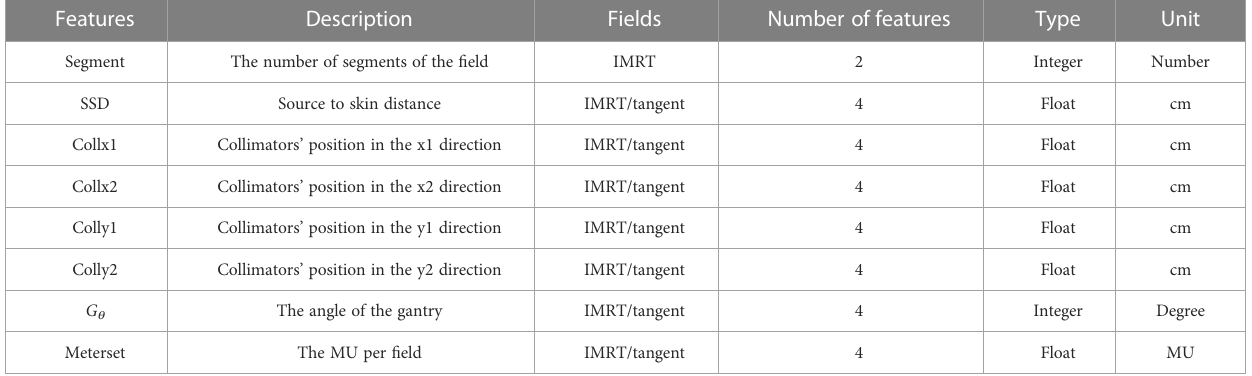
TABLE 1 Description of the features extracted from the treatment